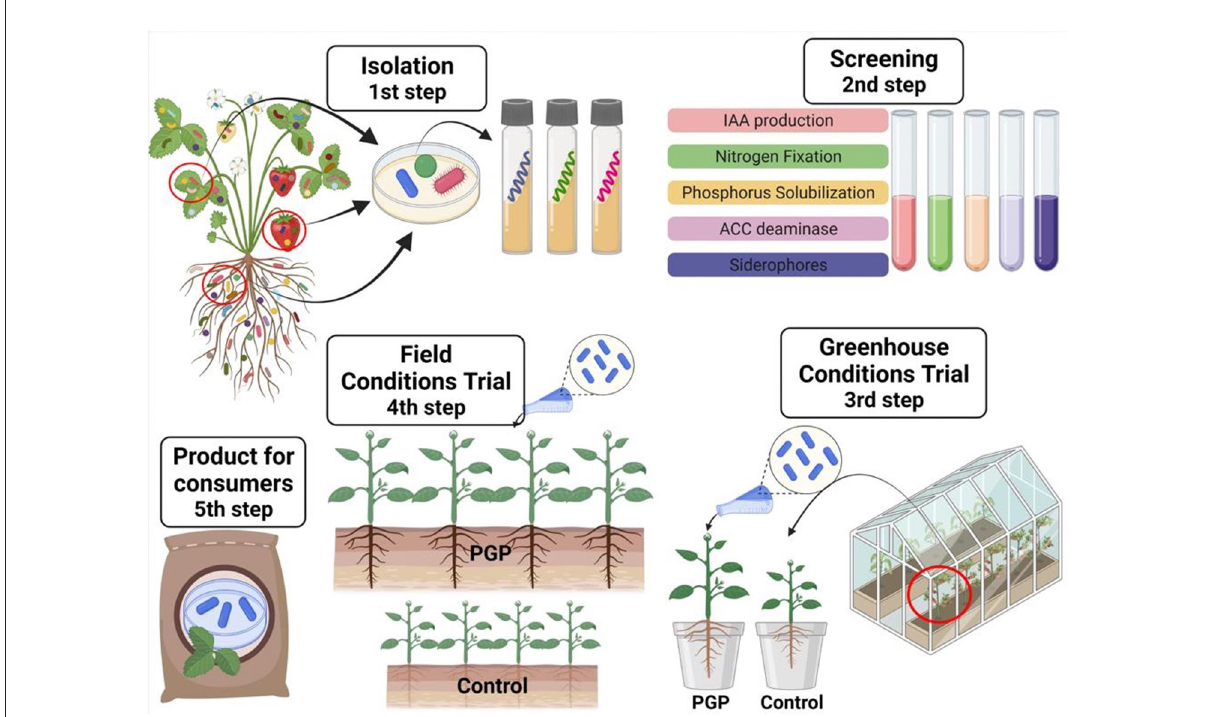
FIGURE1 Schematic representation of the steps required to isolate and characterize bacteria that promote plant